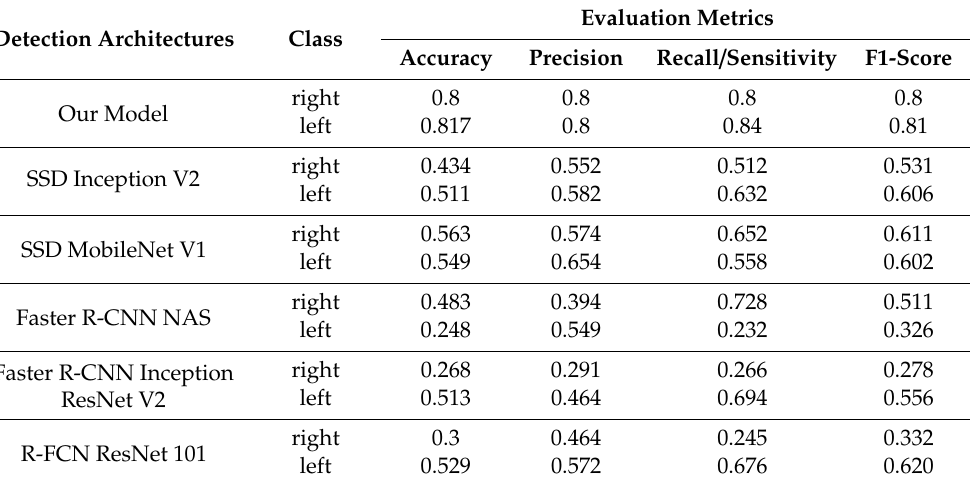
Table 4. Evaluation metrics results of subject-wise testing.